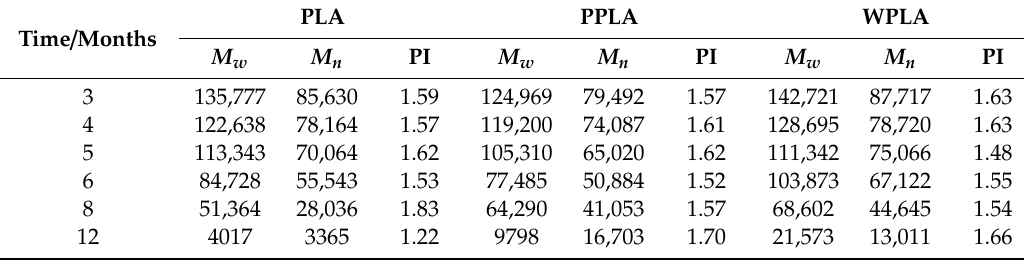
Table 2. Gel permeation chromatography (GPC) data corresponding to the samples. PLA Time / Months